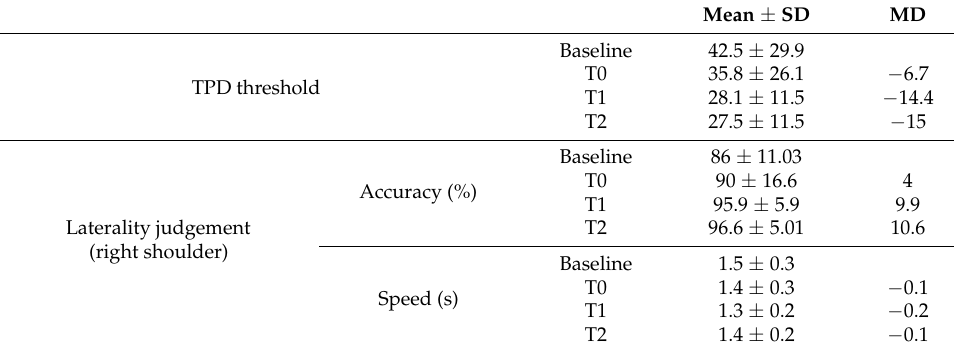
Table 4. TPDT and laterality judgement at baseline, two-week “washout” period (T0), post-treatment (T1), and follow-up